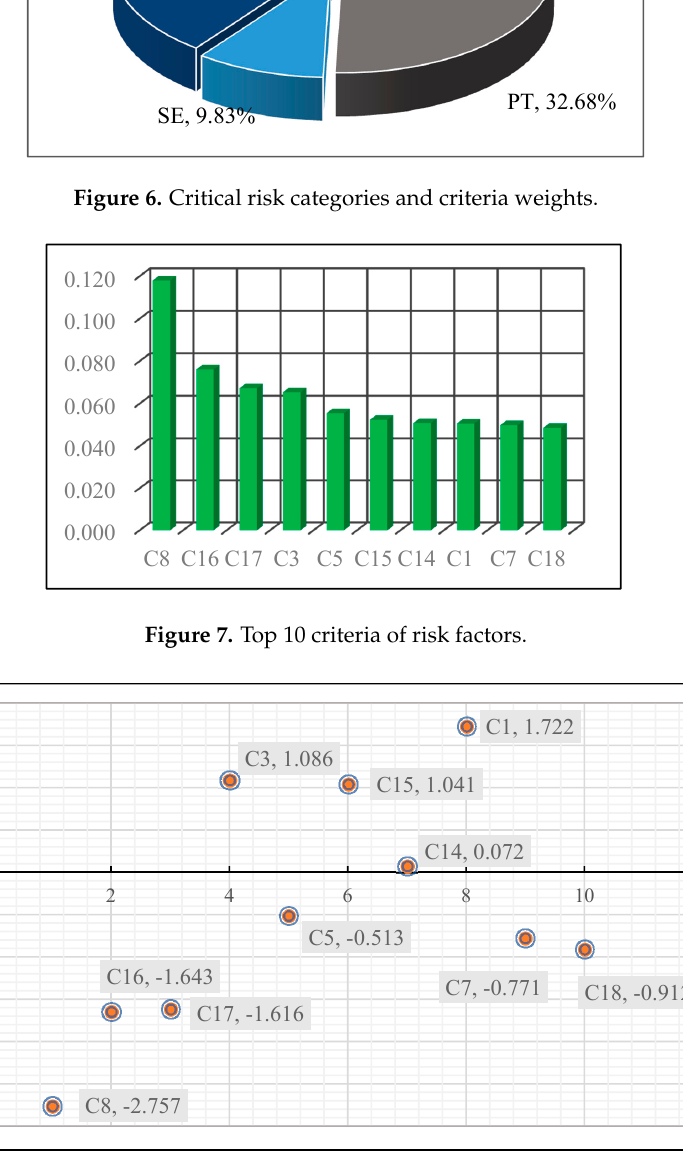
Figure 8. R values of the top 10 risk criteria.